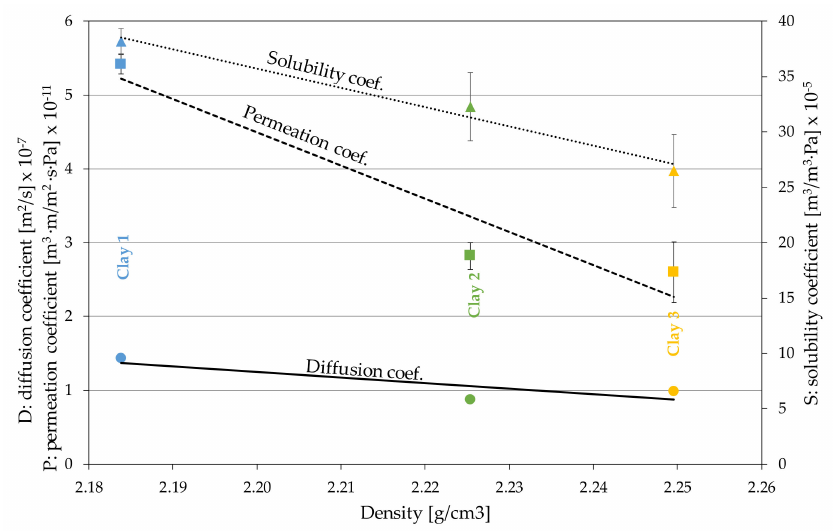
Figure 12. Variation of permeation properties as a function of density in claystone